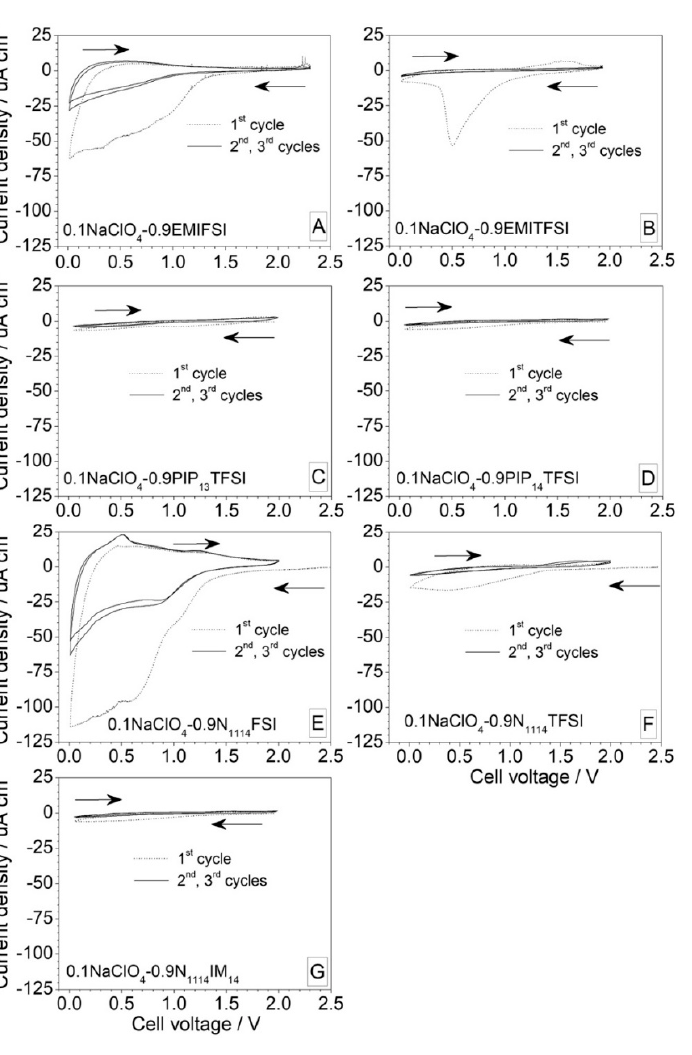
Figure 4. Current-voltage profiles obtained by cathodic CV measurements run on Na/HC cells containing different 0.1NaClO 4 -0.9IL electrolytes (panels from ( A – G )). Scan rate: 0.05 mV s − 1 . Temperature: 20 ◦ C. The voltage values are based on the Na + /Na ◦ redox couple.